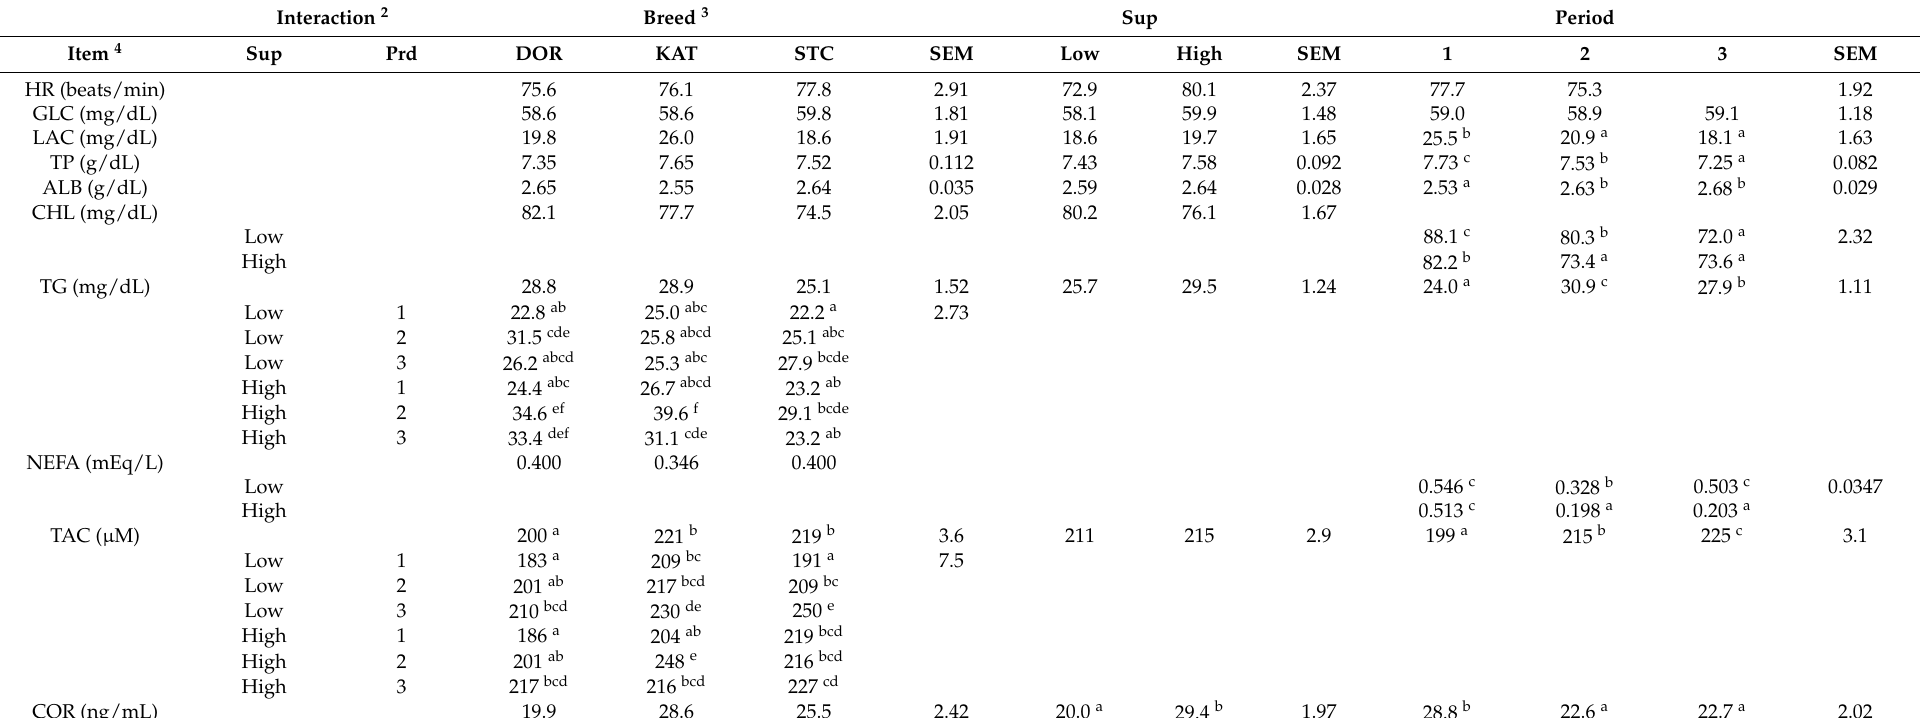
Table 6. Effects of breed, supplementation treatment, and period on heart rate and blood constituent concentrations in hair sheep 1 . Interaction 2 Breed 3 Sup